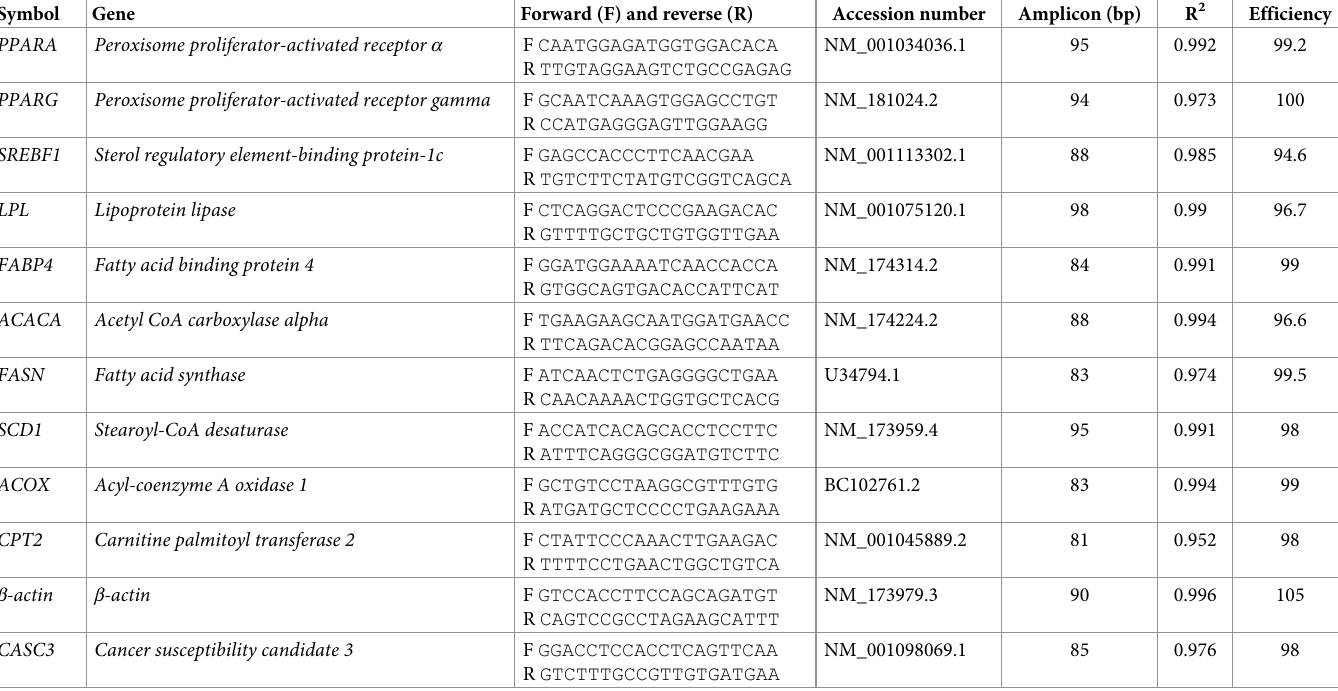
Table 4. Sequence (5’ to 3’) and efficiency of the primers used for